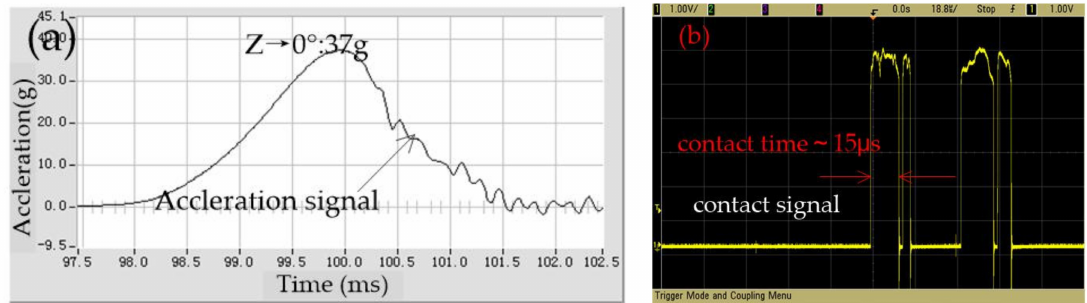
Figure 11. The tested threshold in the z